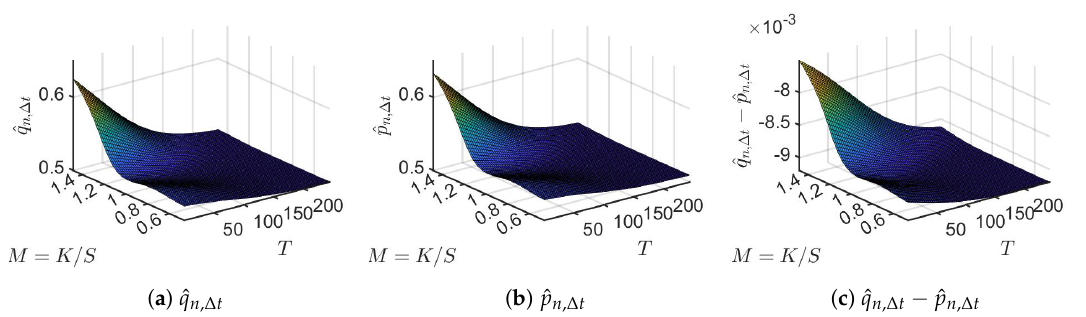
Figure 6. Implied surfaces for ˆ q n , ∆ t , ˆ p n , ∆ t , and ˆ q n , ∆ t − ˆ p n , ∆ t plotted as functions of time to maturity T and moneyness M = K / S